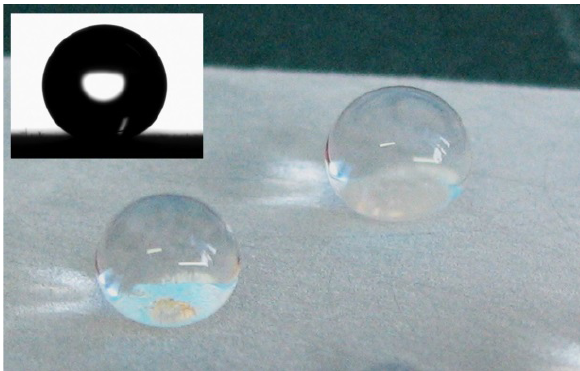
Figure 4: The digital photos of water droplet(s) on the HDPE surface being treated with the scraping, bonding and peeling